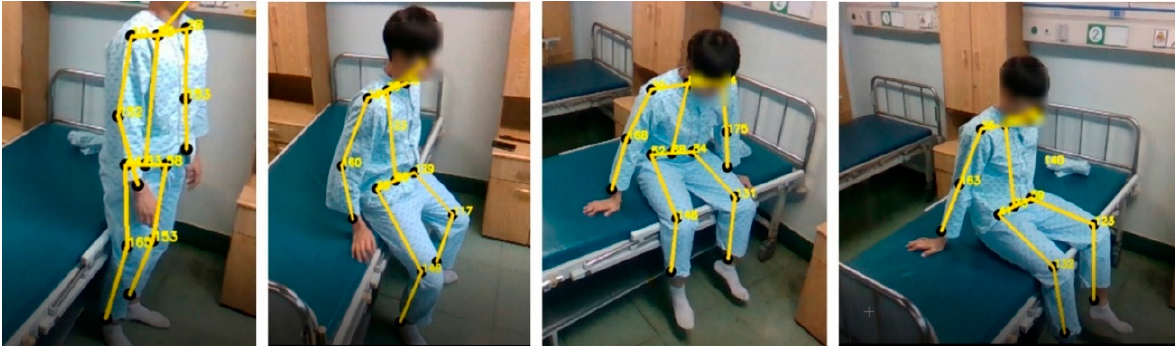
Figure 10. Measurement image of the sitting motion.